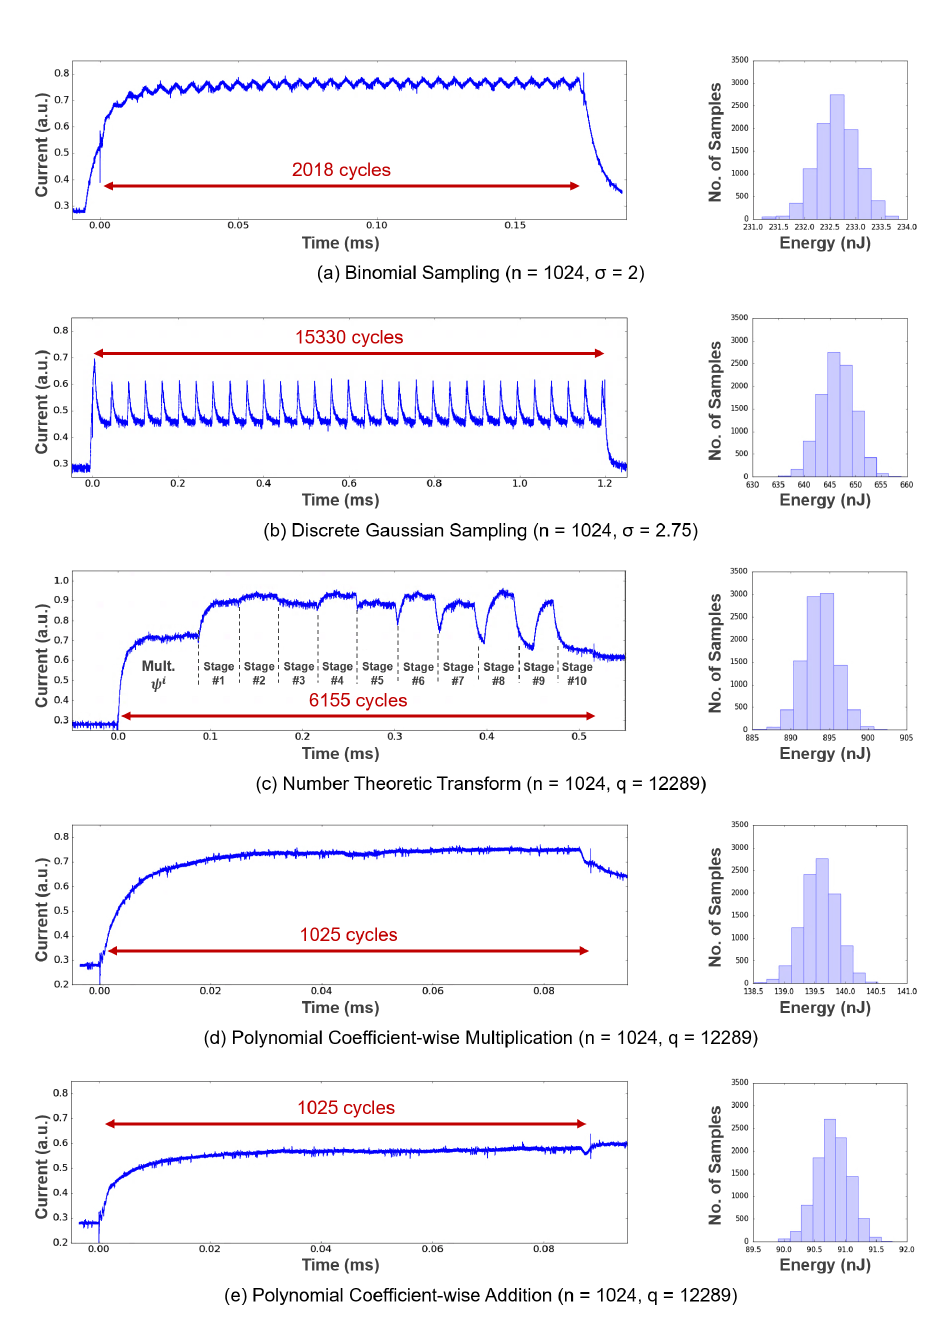
Figure 14: Measured power waveforms for different polynomial sampling, transform and arithmetic operations along with histograms of energy consumption for 10,000 measure- ments for each operation, obtained from our test chip operating at 1.1 V and 12